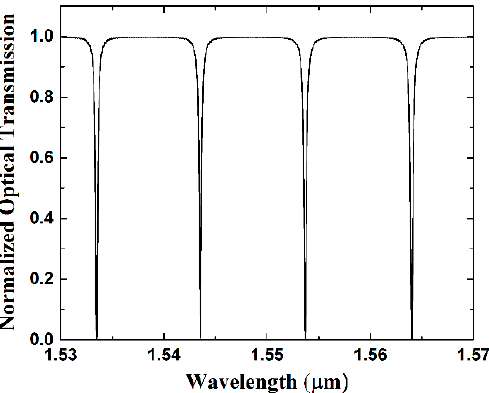
Figure 5. Transmission spectrum of the microring with radius 20 μ m for TM light mode.